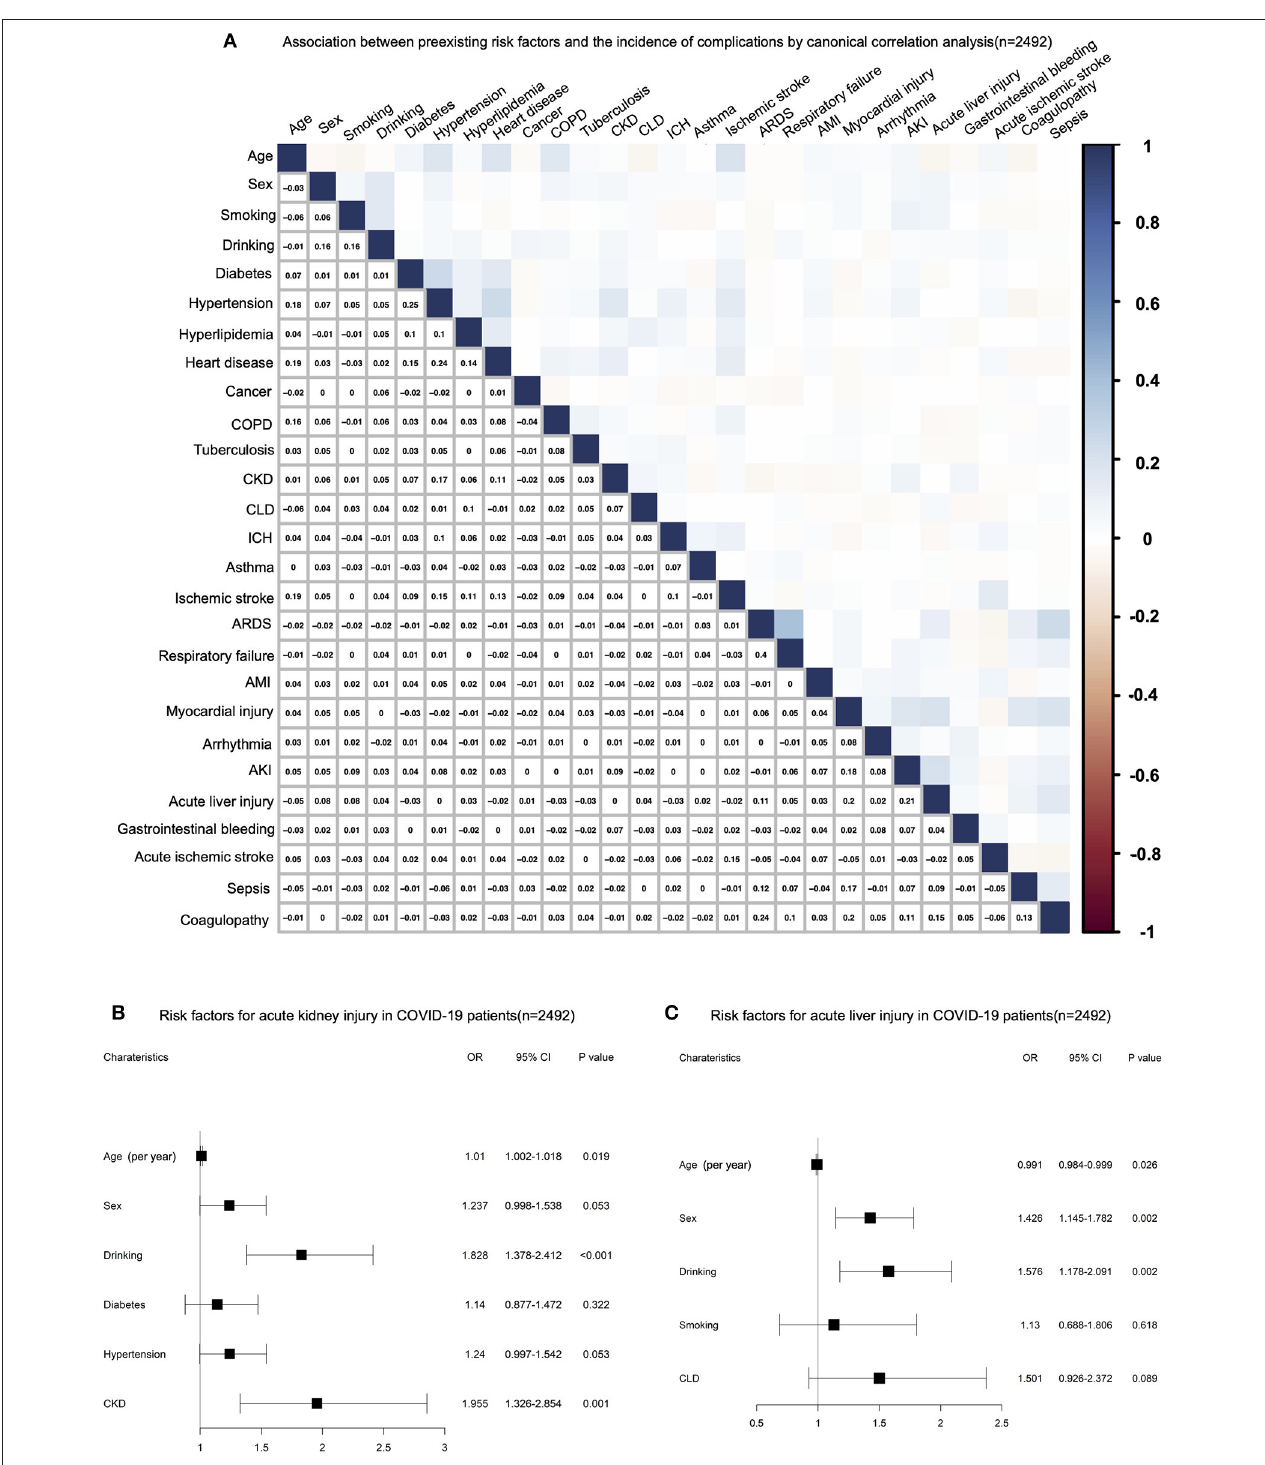
FIGURE 3 | (A) Canonical correlation analysis (CCA) for the relationship between preexisting risk factors and the incidence of complications. (B) Multivariable logistic regression analysis for risk factors of acute kidney injury (AKI) in deceased patients with COVID-19. (C) Multivariable logistic regression analysis for risk factors of acute liver injury in deceased patients with